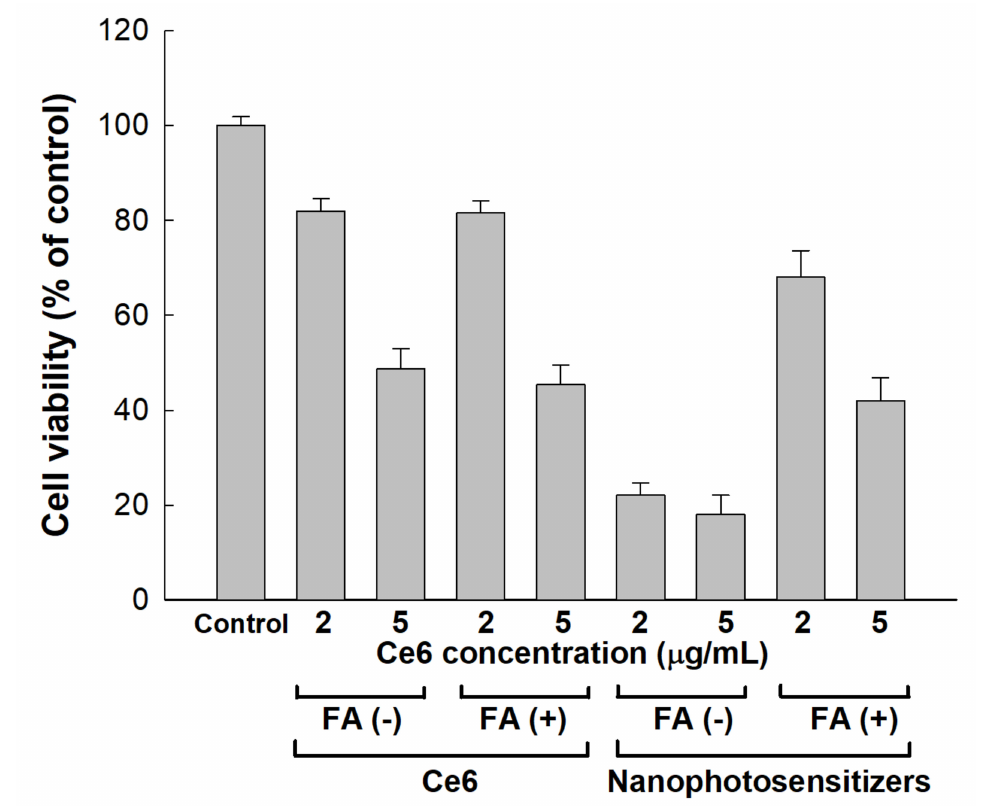
Figure 10. The effect of folate receptor blocking on the viability of HeLa cells. Cells (2 × 10 4 cells/well in 96 wells) were treated with Ce6 or nanophotosensitizers, as described in Figure 9. For blocking the folate receptors, FA (10 mM) was used to pretreat the cells for 30 min to block the folate receptors. Then, the cells were washed with PBS, treated with the Ce6 alone or nanophotosensitizers (2 or 5 µ g/mL Ce6 concentration) for 2 h and irradiated at 664 nm (2 J/cm 2